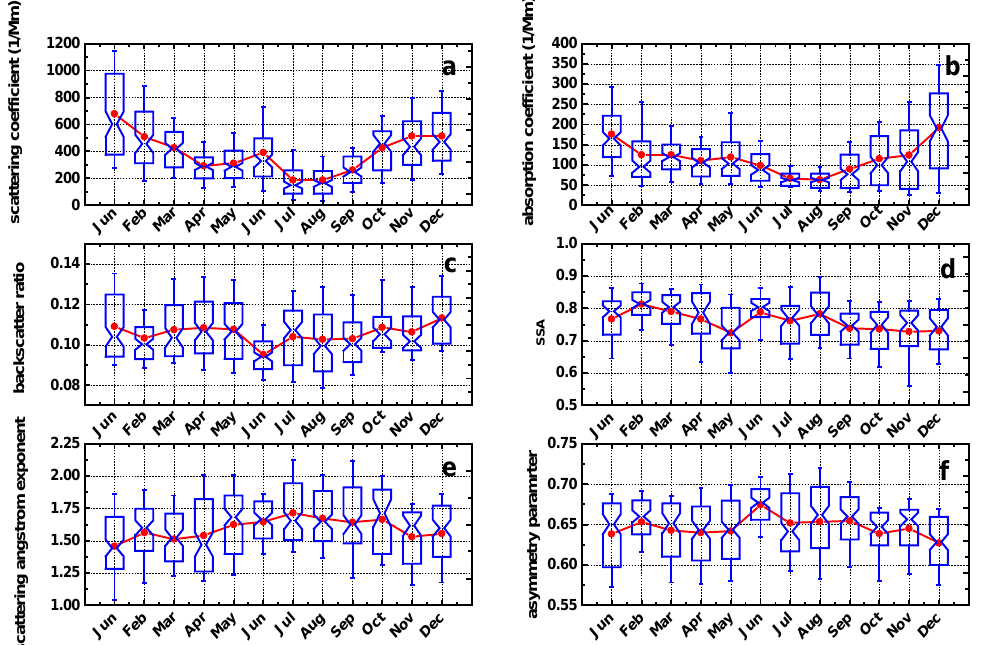
Figure 5. Annual variation curves of aerosol optical properties in the LIESMARS site based on daily means: ( a ) Aerosol scattering coe ffi cients ( σ s ) at 550 nm; ( b ) aerosol absorption coe ffi cients ( σ ab ) at 532 nm; ( c ) backscatter ratio at 550 nm; ( d ) single scattering albedo (SSA) at 532 nm; ( e ) scattering Ångström exponents ( α s ); ( f ) asymmetry factor (g) at 550 nm.